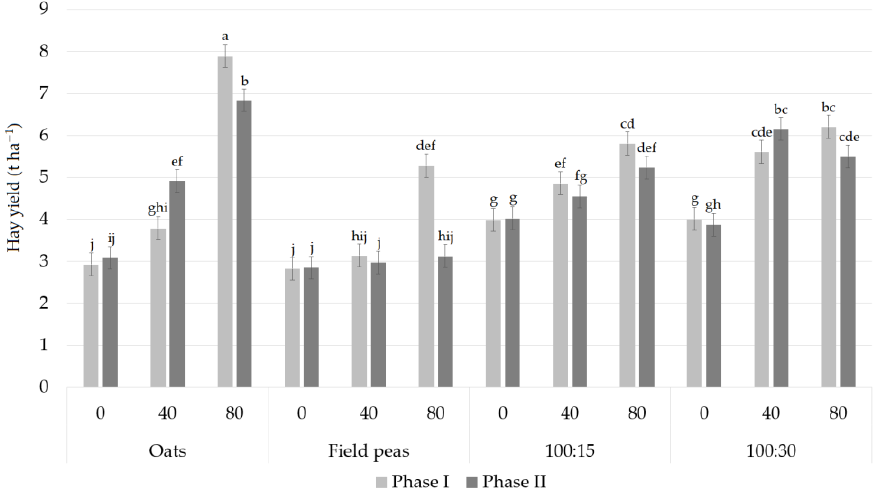
Figure 2. Hay yield of sole crops and their mixture under nitrogen fertilizer (0 kg ha − 1 , 40 kg ha −1 , 80 kg ha − 1 ) and two mowing phases (2017); error bars—standard error; a–j —significant differences between different treatments, a representing the highest value, etc.